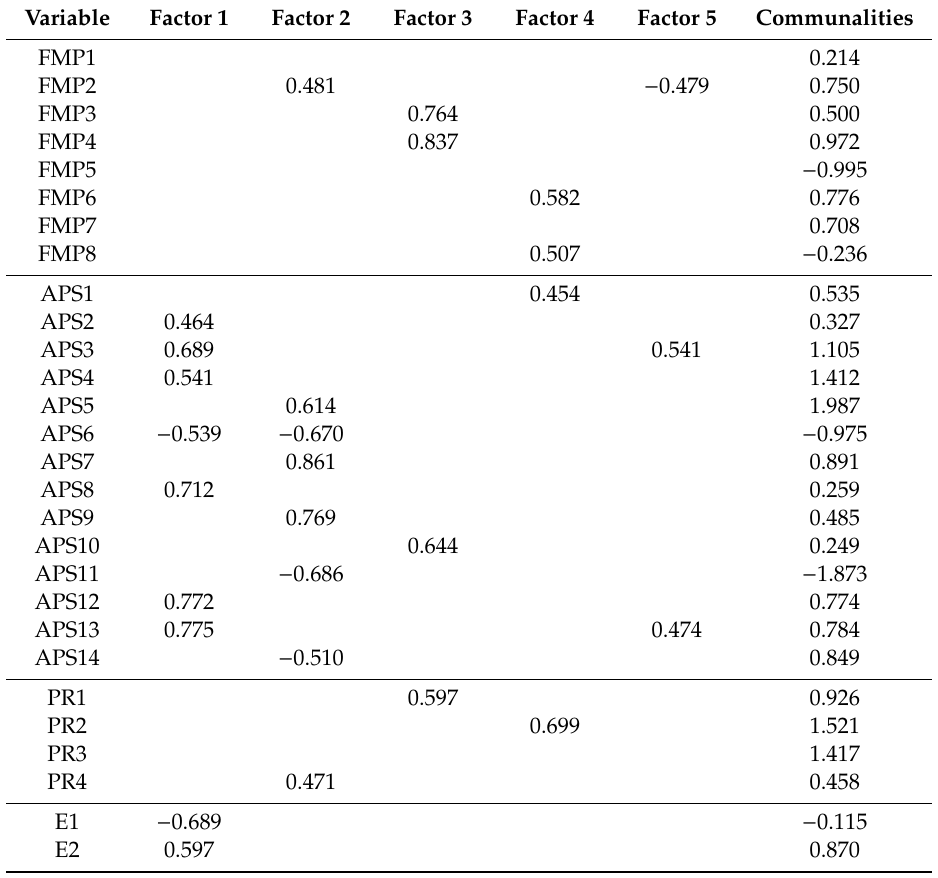
Table 4. Matrix of rotated first five factors loadings. The factor loadings that were smaller in absolute value than 0.45 were